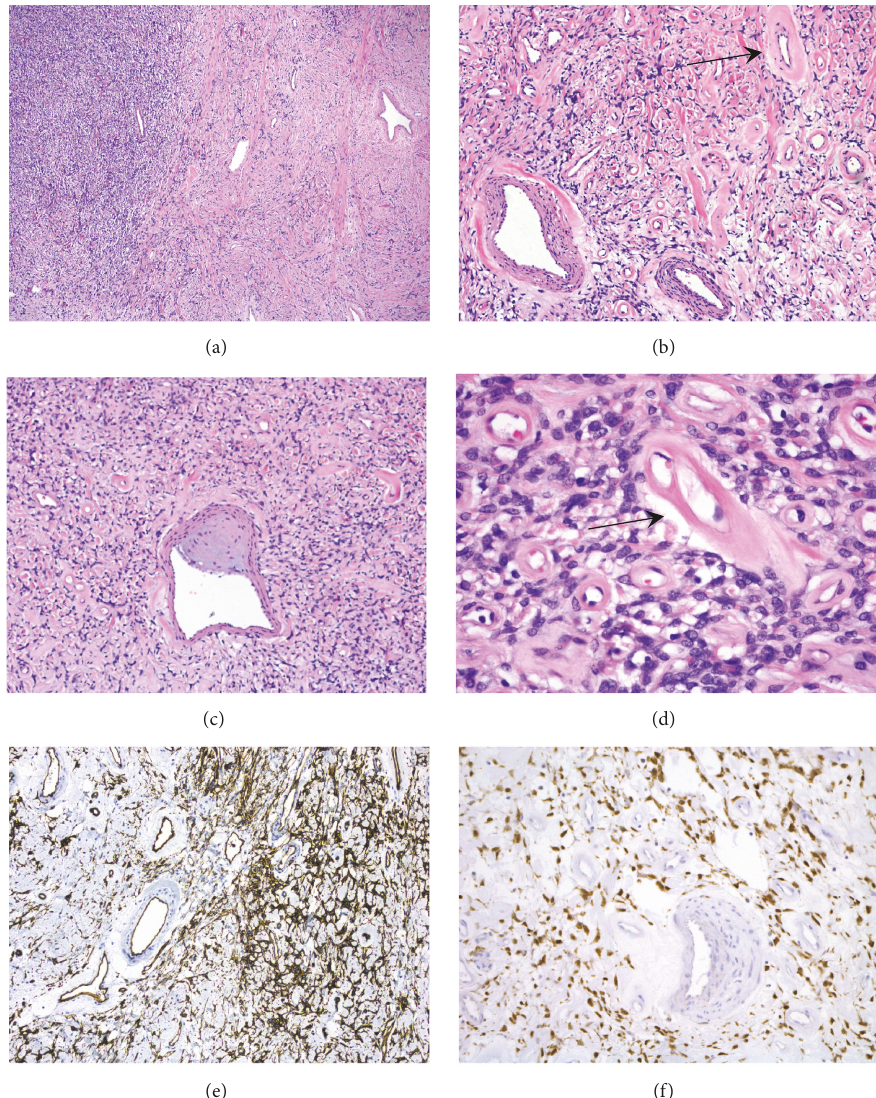
Figure 3: Microscopic features and immunohistochemical results. (a) Typical hypo- and hypercellular areas of the tumor (H&E, x40). (b) Vessels containing proliferating myocytes associated with complete mural hyalinization (arrow) (H&E, x100). (c) A vessel with mural myxoid degeneration (H&E, x100). (d) Bland looking neoplastic cells with oval to fusiform nuclei and little cytoplasm around hyalinized small vessels (arrow) (H&E, x400). (e) Numerous hemangiopericytoma-like vascular channels (CD34, x100). (f) STAT6 immunostain showing strong diffuse nuclear positivity in the neoplastic cells. The vascular myocytes are negative (STAT6, x200).